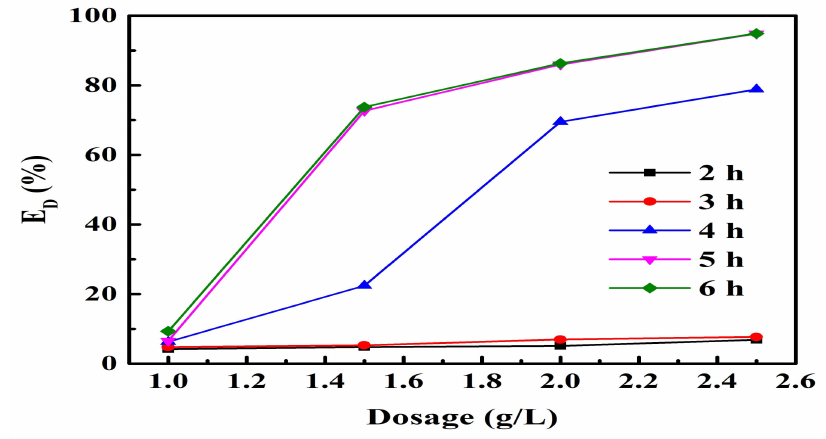
Figure 8. Demulsification performance of Ti-Mt-APTES-0.1 under various stirring times.